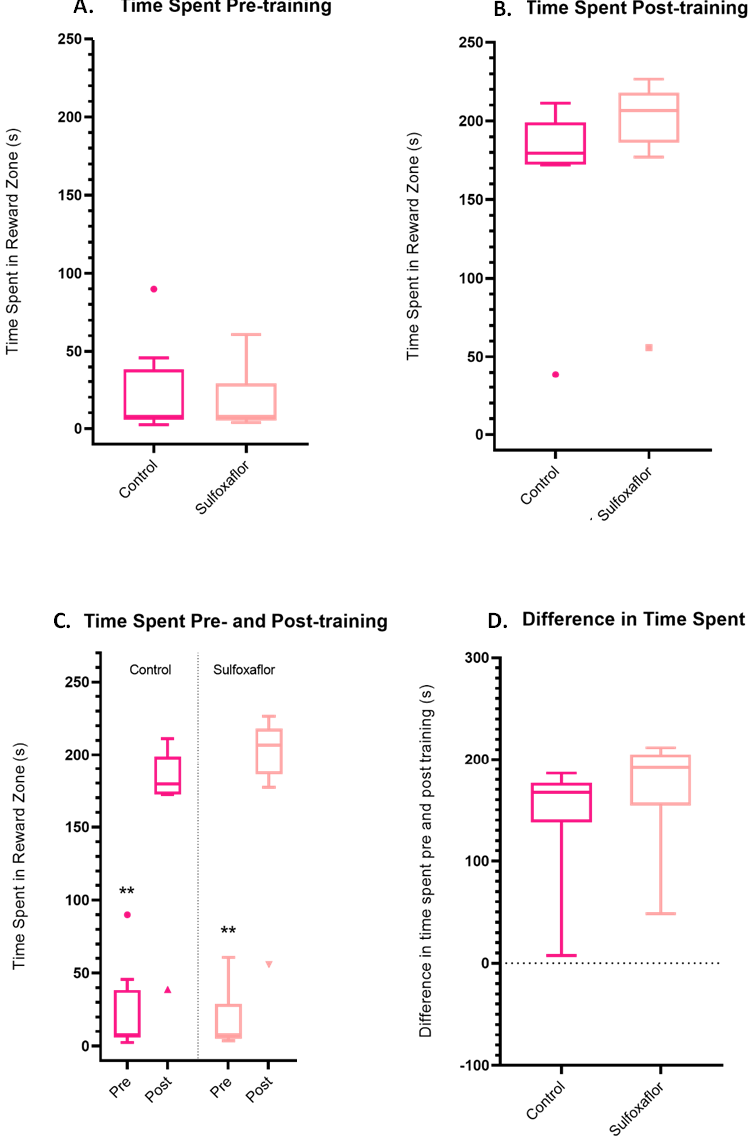
Figure 7. Time spent in the reward zone pre- and post-training by bees in the high-dose trials. ( A ) Time spent pre-training. p (cid:61) 0.99 for all comparisons, Kruskal-Wallis test. ( B ) Time spent post-training. Control vs. sulfoxaflor p (cid:61) 0.99. ( C ) Time spent pre- versus post-training. Control p = 0.004 **, sulfoxaflor p = 0.004 **. ( D ) Differences in time spent (post-training − pre-training value). Control vs. sulfoxaflor p (cid:61) 0.99. Control n = 9, sulfoxaflor n = 9. Coloured circles ( • ) and triangles ( (cid:78)(cid:72) ) represent individual bee outlier data.